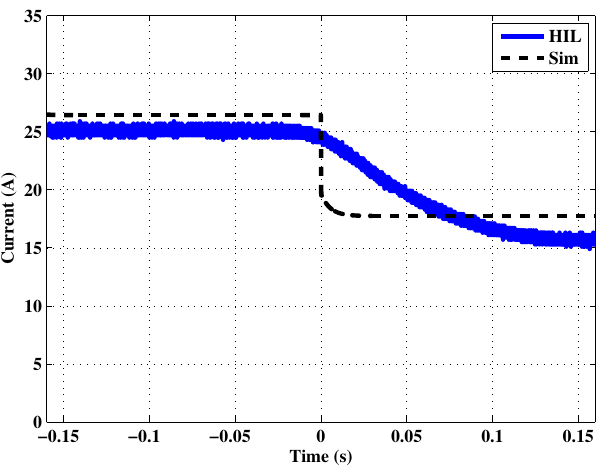
Figure 12. Simulation and hardware-in-the-loop results for Source 2 current during a step change in wind speed.